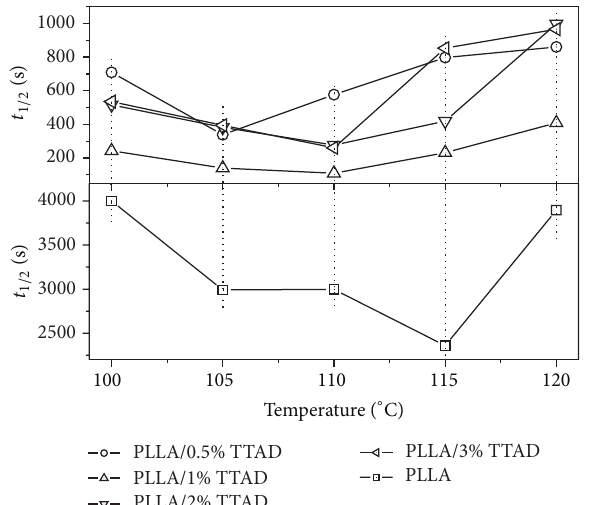
Figure 6: The half-time of overall crystallization of PLLA and PLLA/TTAD with the crystallization temperature and TTAD con- tent.